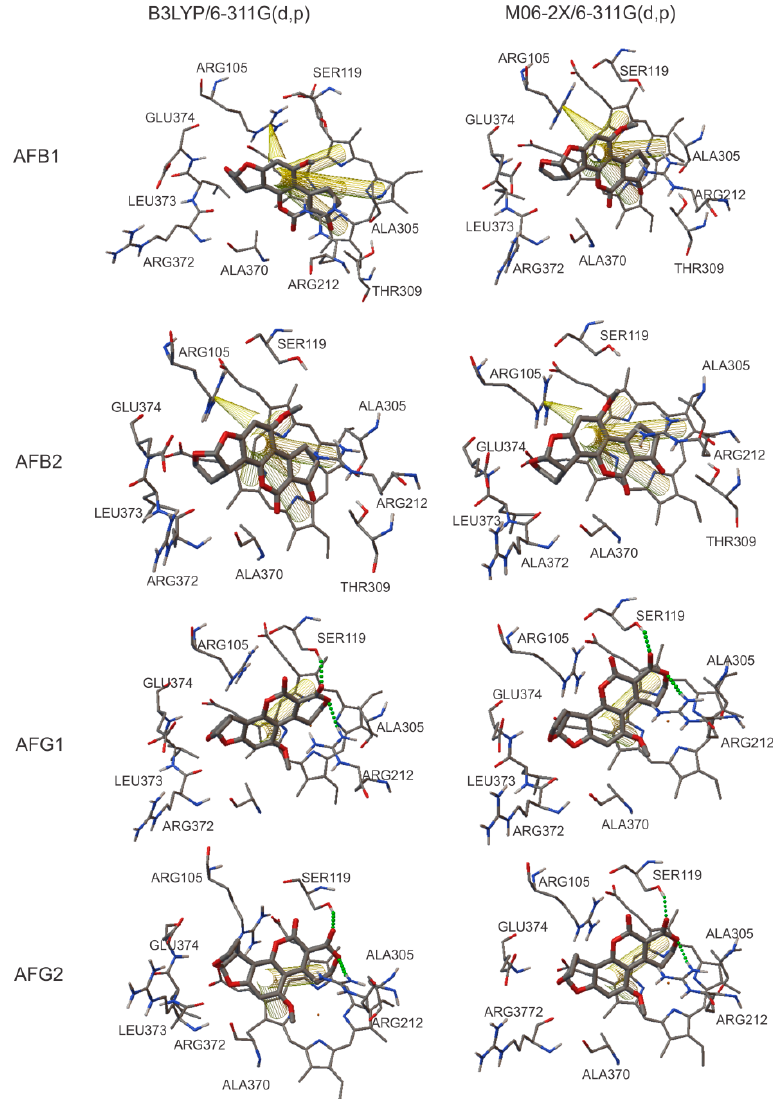
Figure 3. Analysis of the molecular interactions in the active site of CYP 3A4 (1TQN PDB ID) with ligands AFB1, AFB2, AFG1, and AFG2. π – π interactions are indicated as yellow tubes and hydrogen bonds are indicated with green dotted lines .